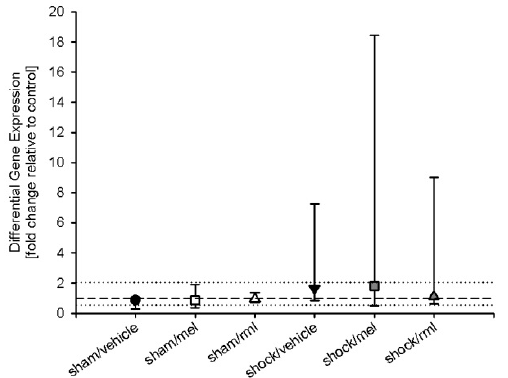
Figure 3. Analysis of di ff erential expression of melatonin receptor type 1 messenger ribonucleic acid displayed no significant di ff erences between groups. The dashed line indicates the mean of sham / vehicle; the dotted lines indicate a ratio of 0.5 for downregulated genes and 2.0 for upregulated genes. Data are expressed as median ± 25th / 75th percentile ( n = 8). rml = ramelteon; mel = melatonin.